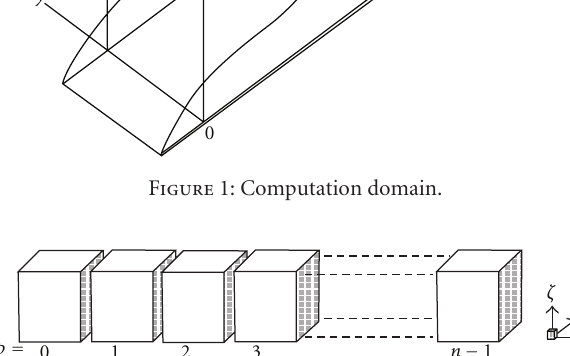
Figure 2: Domain decomposition along the streamwise direction in the computational